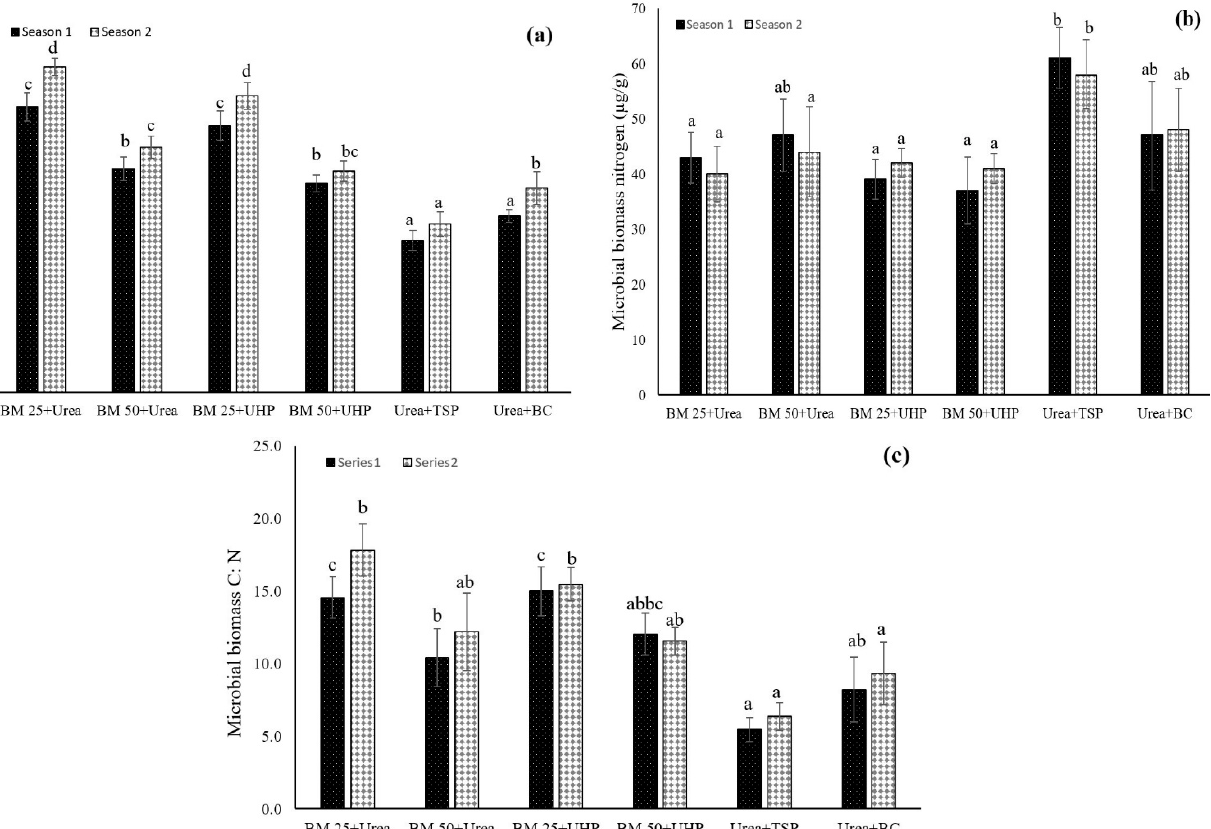
Figure 5. Microbial biomass ( a ) C, ( b ) N, and ( c ) C: N ratios of the soil under different amendments at the end of each lettuce growing season.